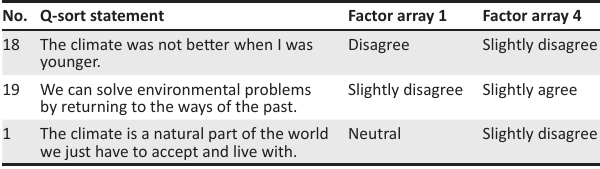
TABLE 3: Factor arrays of Q-sort statements related to Afro-polychronic time orientation. No. Q-sort